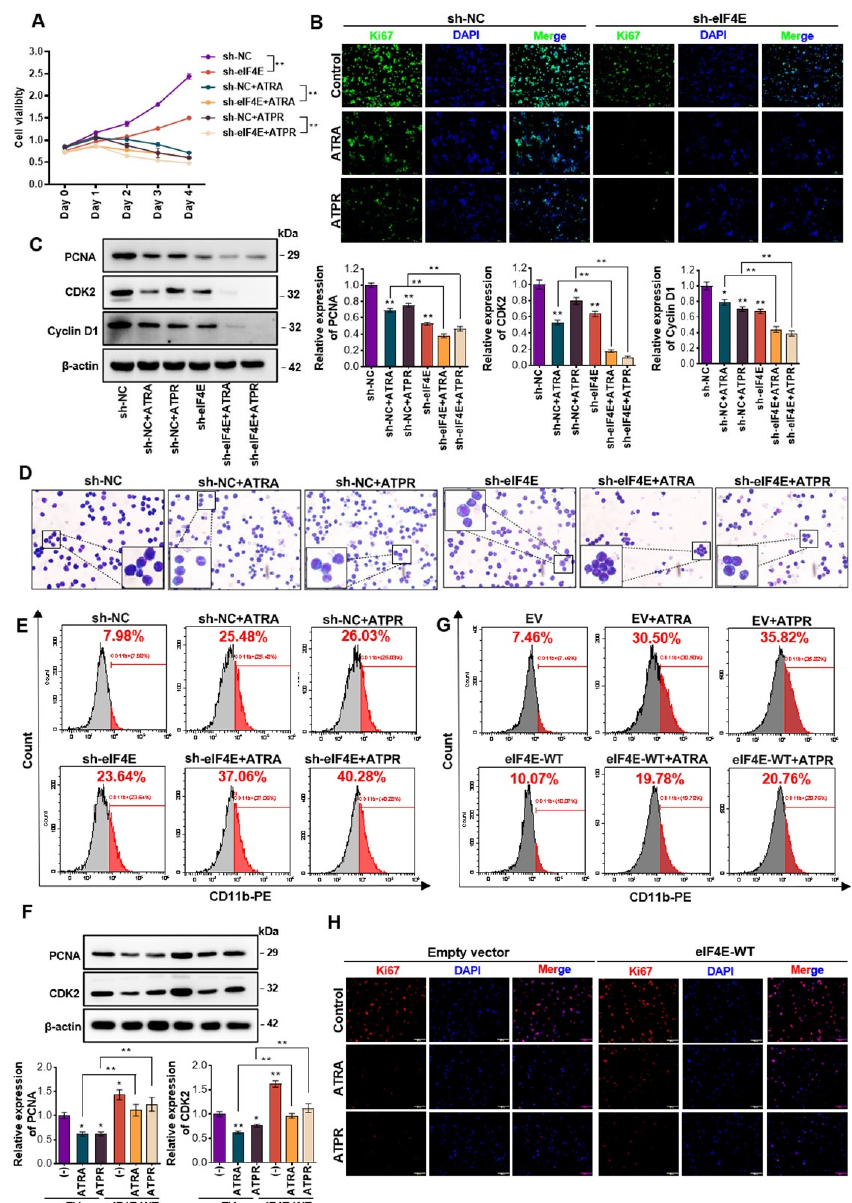
Figure 2. eIF4E was a critical regulator in ATRA or ATPR-induced AML cell growth arrest and differentiation. ( A ) Molm13 cells were infected with lentiviral-based shRNA targeting eIF4E or a negative control scramble shRNA and then exposed to ATRA or ATPR. Cell growth/proliferation was evaluated by cell counting kit-8 (CCK-8). ( B ) Immunofluorescent staining showing proliferating Molm13 cells by labeling endogenous Ki67 (Green) with DAPI (Blue); bar, 100 µ m. ( C ) Western blot analysis and quantification of proliferating cell nuclear antigen PCNA and cell cycle regulators CDK2 and CyclinD1. ( D ) Wright-Giemsa staining showing the morphological maturity of Molm13 cells after specific treatments. Purple: Nuclear. Blue: Cytoplasm. Bar, 50 µ m. ( E ) The proportion of cell differentiation marker CD11b-positive Molm13 cells was analyzed by flow cytometry. ( F ) eIF4E was overexpressed in Molm13 cells by lentiviral-based eIF4E-WT or negative control scramble plasmids infection, and then cells were treated with ATRA or ATPR. Cell proliferation was assessed by protein levels of PCNA and CDK2 and detected by Western blot. ( G ) Cell differentiation was analyzed by the proportion of CD11b-positive cells and detected by flow cytometry. ( H ) Immunofluorescent staining of Ki67 (Red) with DAPI (Blue) in Molm13 cells from the indicated groups; bar, 100 µ m. * p < 0.05, ** p <